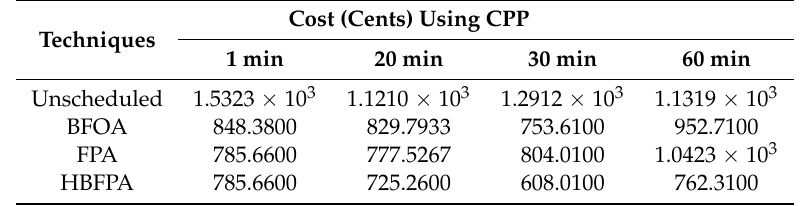
Table 5. Electricity cost for 24 h (for single home).